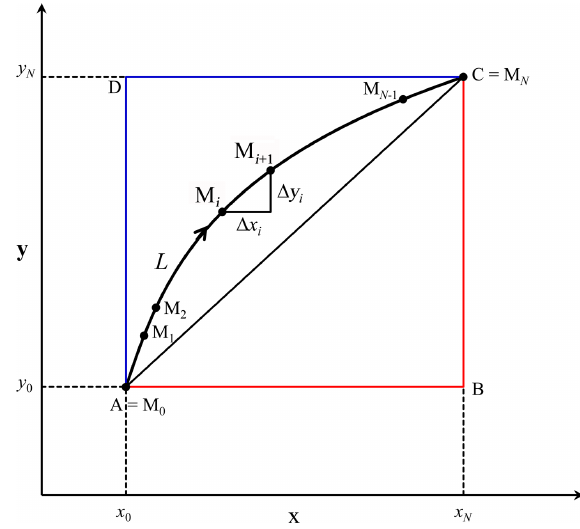
Figure 2. A schematic plot illustrating the decomposition method. Point A denotes the initial state (the reference period), and point C denotes the terminal state (the evaluation period). The decompo- sition method assumes that the catchment state first evolves from Point A to B along the Budyko curve for the reference period, then jumps to Point C. R 2 represents the mean annual runoff of the eval- uation period, and R 2 (cid:48) the mean annual runoff given the climate conditions of the evaluation period and the catchment conditions of the reference period. See Sect. 2.4 for details.